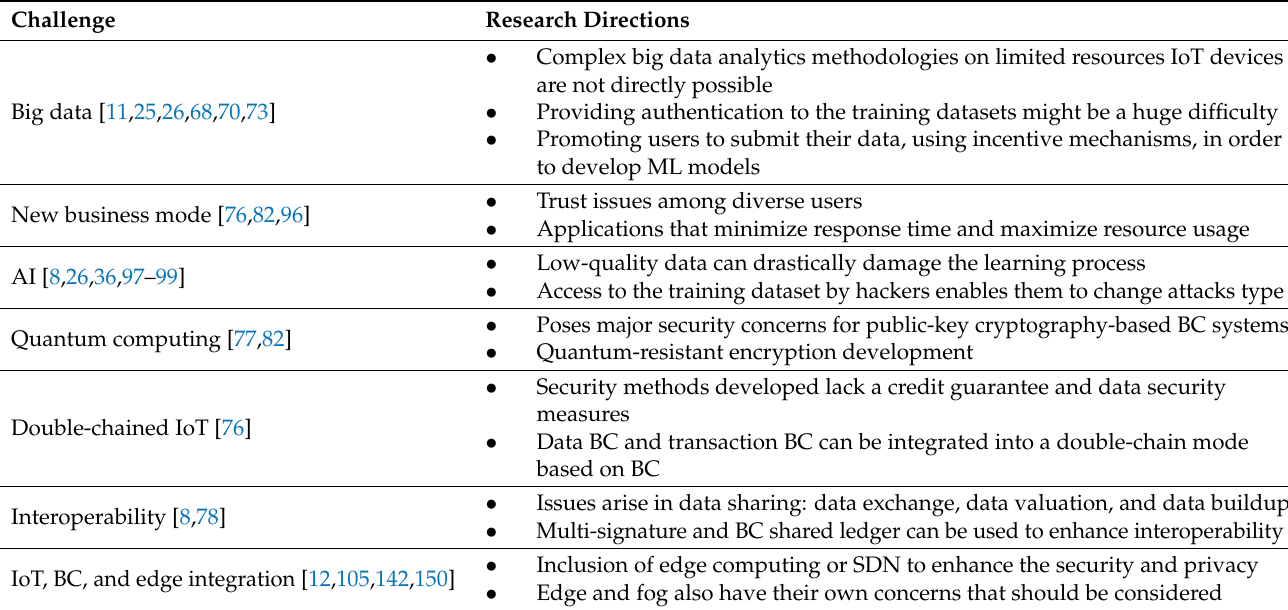
Table 13. Summary of future challenges and